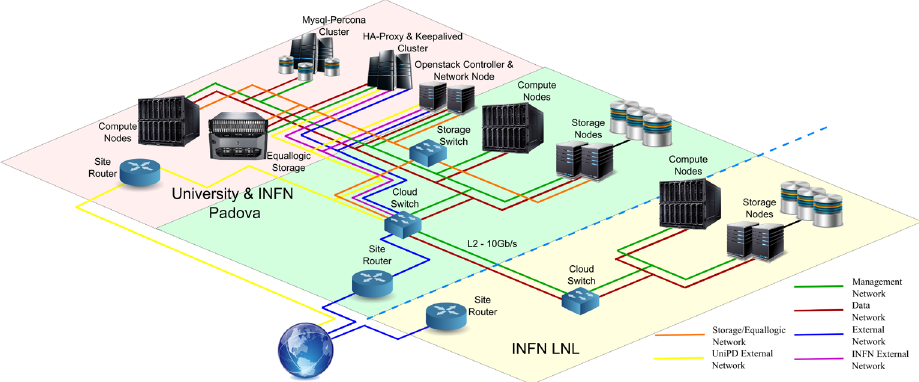
Figure 1. The CloudVeneto